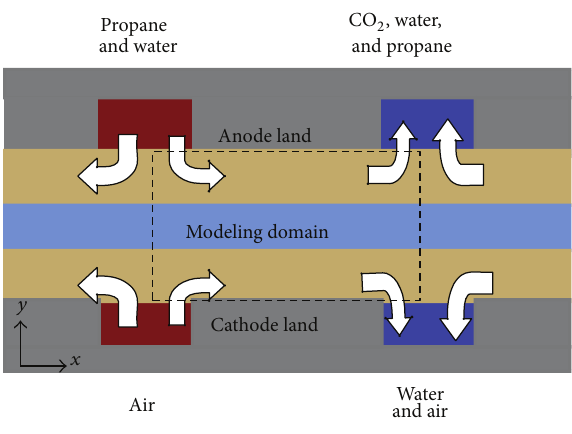
Figure 2: Boundaries in the modeling